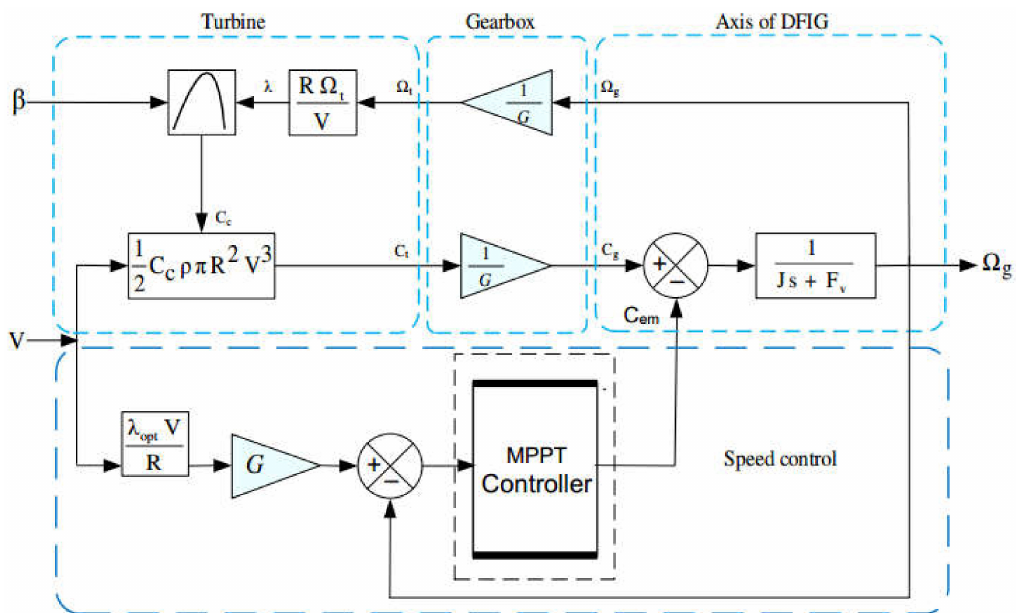
Figure 4. MPPT Strategy with speed control.